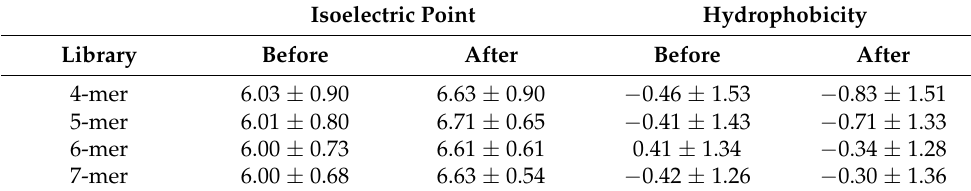
Table 1. Distribution average of peptides on a 3D color map before and after the first screening.